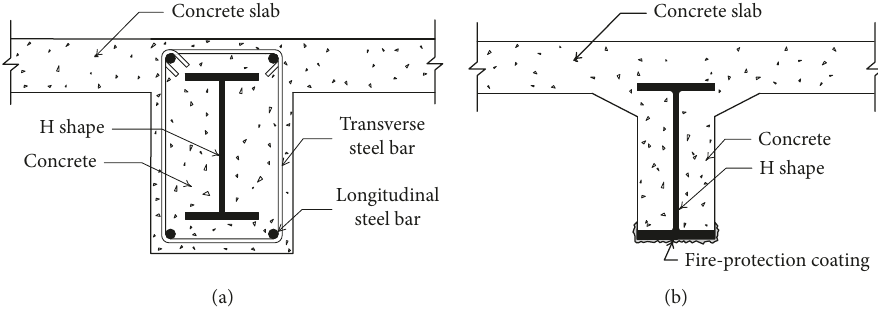
Figure 1: Concrete encased steel beam; adapted from “Behavior of Partially Concrete Encased Steel Beams under Cyclic Loading” [1]. (a) Fully concrete encased steel beam/SRC. (b) Partially concrete encased steel